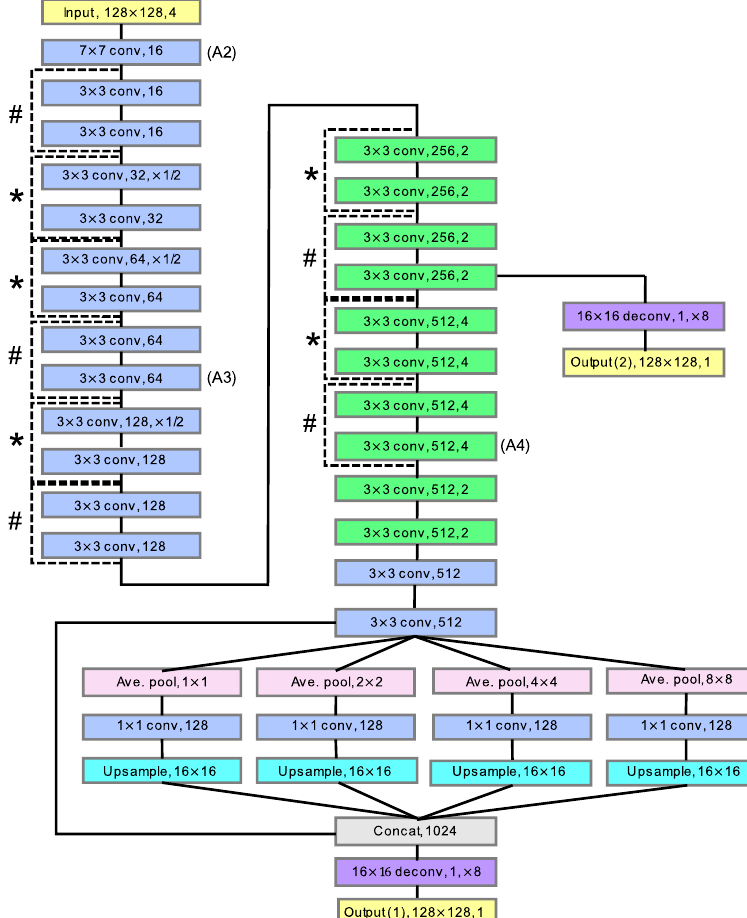
Figure 9. Structure of the CNN proposed in the present study for the estimation of slant-column COT (SCOT) from sky camera images. The input is three spectral channels with an additional solar position image. Layers denoted in light green represent the dilated convolutional layers with the shown filter size, number of output channels, and dilation parameter. The filters and an example of the feature maps of the layers denoted by (A2), (A3), and (A4) are presented in Figures A2–A5. The other notations are the same as in Figure 4. More details are explained in the text.